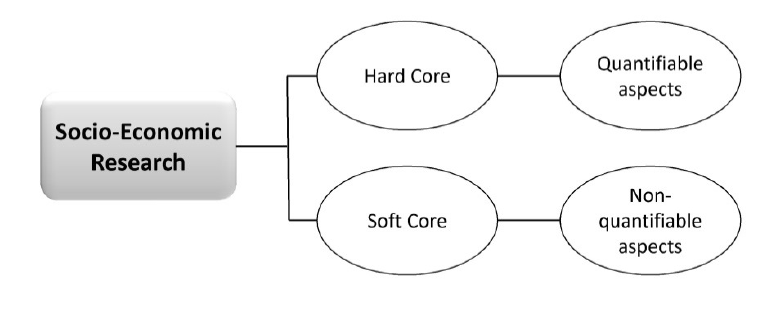
FIGURE 1: Aspects pertaining to socio-economic research Source: Authors’